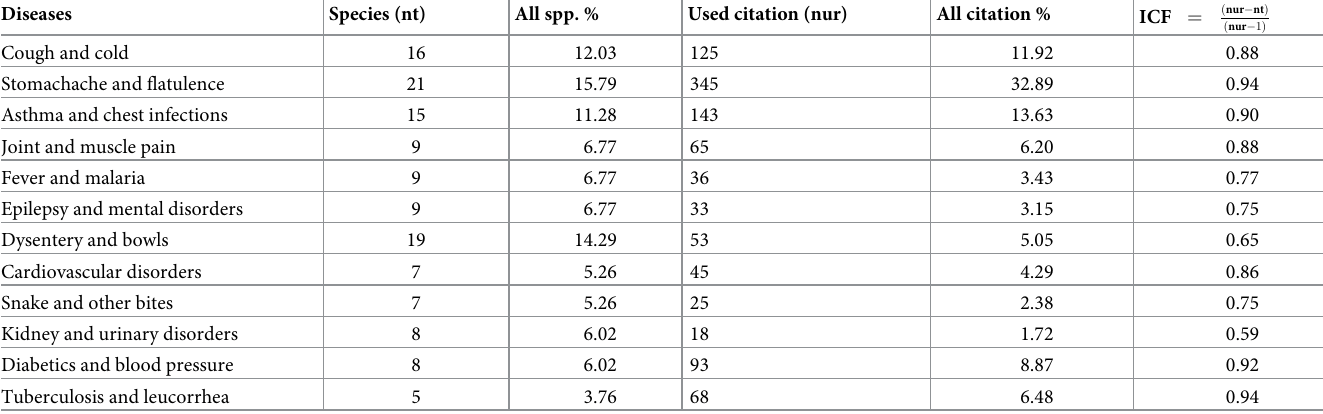
for diseases group “tuberculosis and leucorrhea”, followed by stomachache and flatulence (0.93), diabetics and blood pressure (0.92) and asthma and chest infections (0.88) as shown in Table 9. The high values of ICF for Tuberculosis (TB), asthma and chest infections may be use of cold and high mountaineous house where smoke of burning of wood (used for fuel purpose to cook and heating purpose) causes lungs infirmities. Feminist disease leucorrhea’s high rate might be due to excessive eating of high energy (hot) foods to combat cold environment. The common occurrence of diabetics and blood pressure may be due to changes in life style and excessive uses of fat/ghee by the indigenous people. These findings are corroborate with previ- ous research works [26,27]. The comprehensive ICF analysis depicted that similar types of infirmities were reported in other areas of AJK [53,56,65,66] and Pakistan [54,55,58,73–76]. The other common use of plants was fuel with ICF (0.83) purpose which is pivotal source for cooking and heating the rooms in chilling cold weather. The second was and thatching (ICF = 0.82) where people use plants or their parts for construction/thatching houses because people in study areas only depends on tree for houses/shelter formation. The lowest value is for fodder 0.18 (Table 10). Similar findings were correlated and strongly supported by Farooq and his colleagues [26]. Our both ICF results for ethnomedicines and ethnobotanical were coincidence with past researchers published by different scientists in rest of the world [30]. According to direct matrix ranking (DMR) analysis was calculated to determine biotic pres- sure and conservation status of different plant species being used by indigenous people of the Table 9. Informant consensus factor (ICF) for different diseases categories from Dawarian and Rati Gali, AJK, Pakistan. Diseases Species (nt) All spp. %